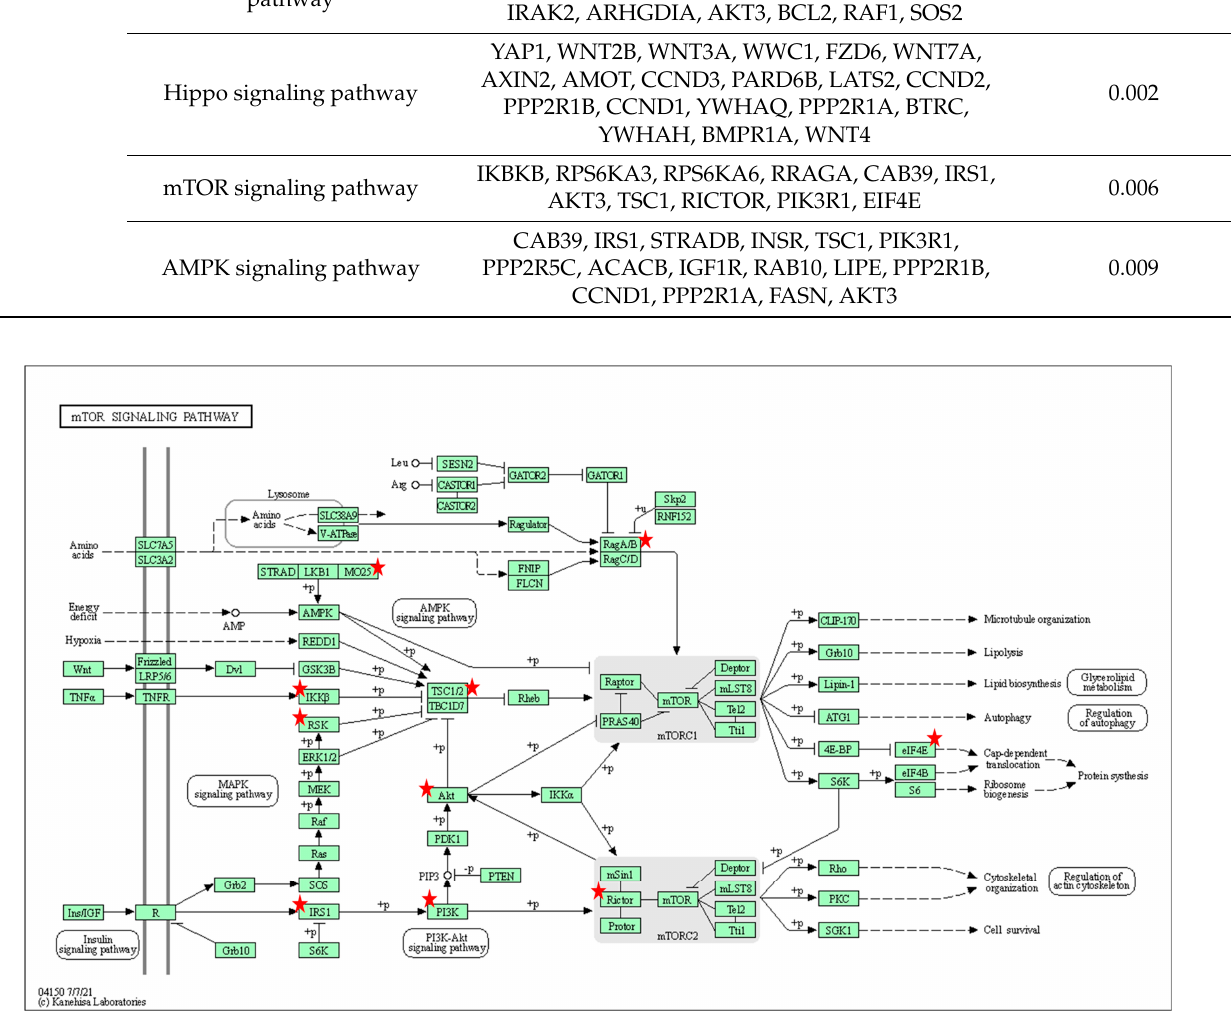
Figure 4. Gene ontology (GO) analysis using the DAVID software. Role of the affected genes (indicated as red stars) within the mTOR signaling pathway associated with miR-378.